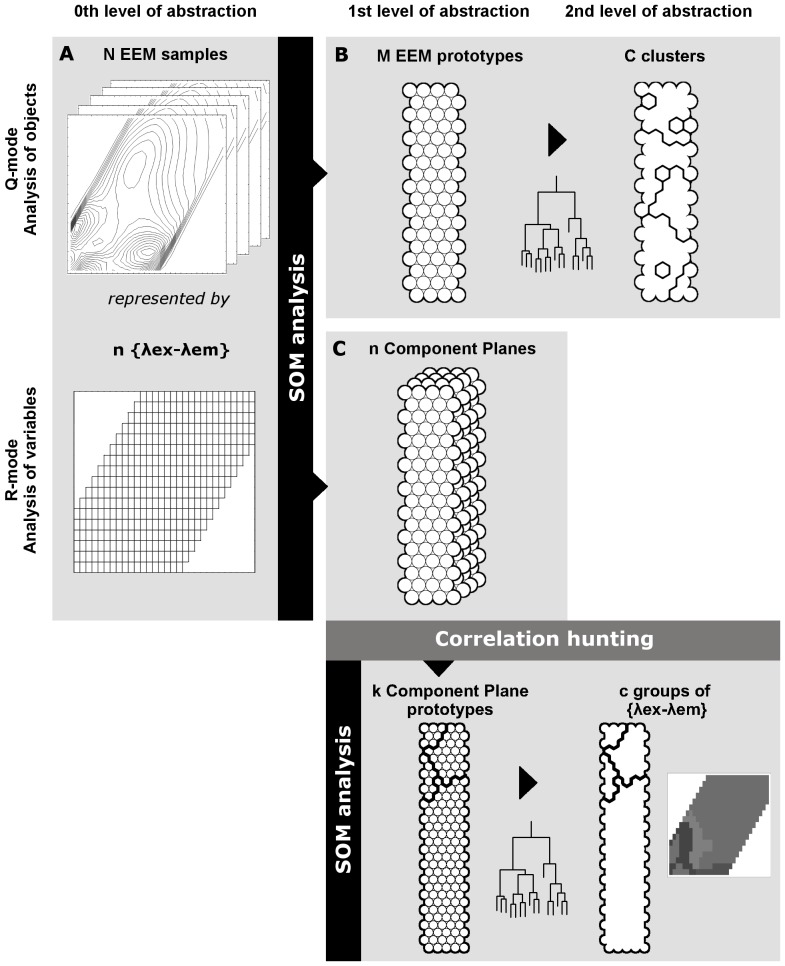
Summary of the methodology applied in this study.A) N initial samples are reduced to M prototype EEMs by SOM analysis. B) EEM prototypes are clustered to facilitate exploration of the relationships between the sample EEMs. C) SOM is performed on the correlation matrix of the component planes of the Q-mode SOM analysis. The output corresponds to an aggregation of highly correlated wavelength coordinates in a single neuron unit. D) Neuron units are clustered in order to find groups of highly correlated wavelength coordinates. E) Wavelength coordinate clusters are displayed in an EEM optical space in order to evaluate their biogeochemical meaning. Adapted and extended from Vesanto and Alhoniemi [38].